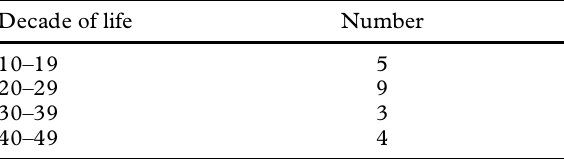
Table 1. Ages of patients with periosteal osteosarcoma Decade of life